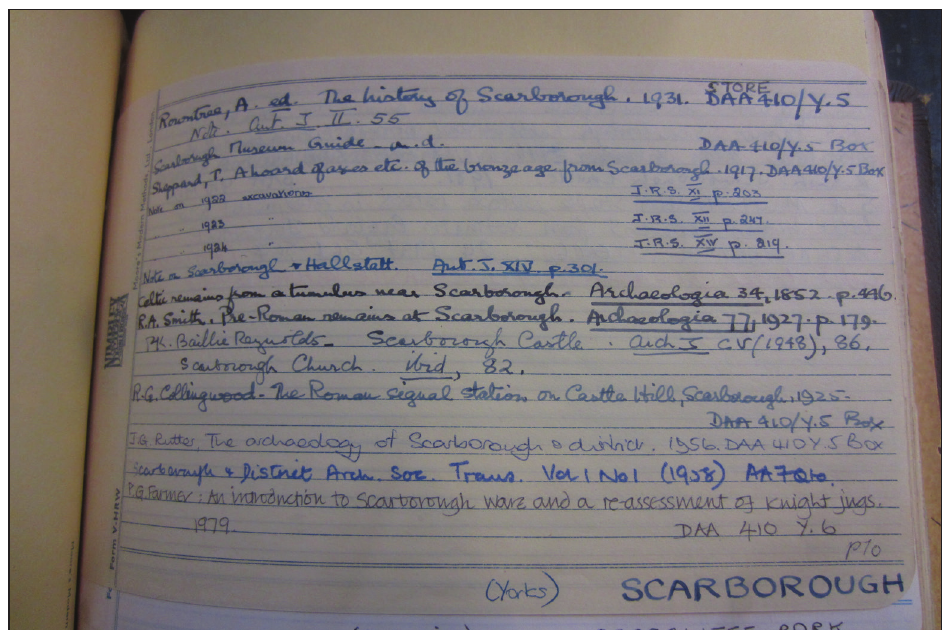
Figure 3: Entry for Scarborough from the Site Index (Photo UCL Library